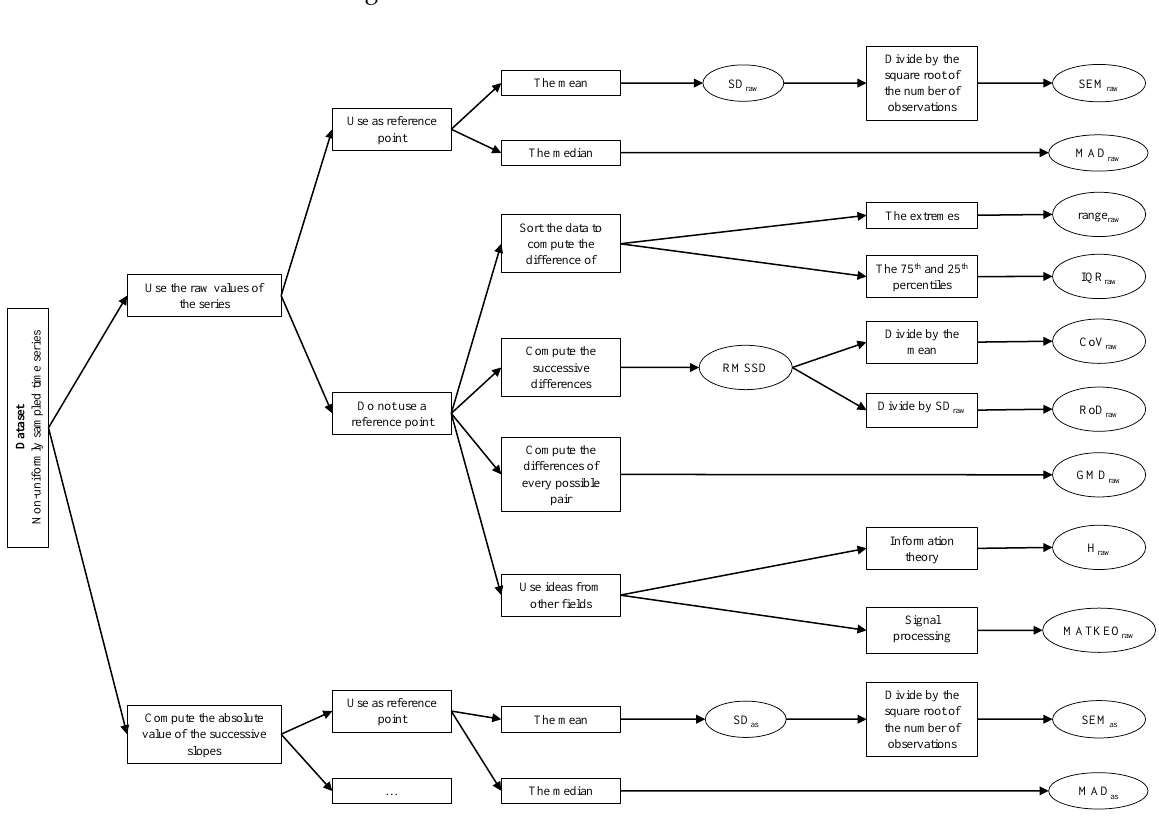
Figure 1. Block diagram of the analyzed variability measures. The ellipsis is used to prevent repetition of the blocks for the metrics based on the absolute value of the successive slopes. The meaning of all quantities can be found in the table of